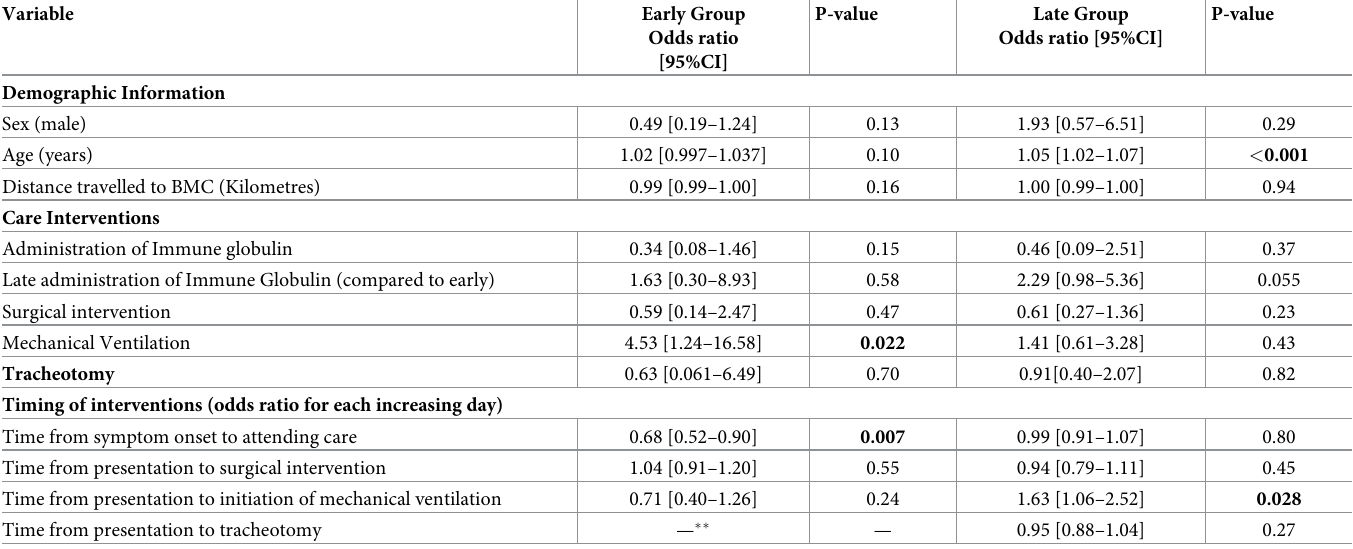
Table 4. Results of univariable analysis of predictors of overall mortality in the early and late